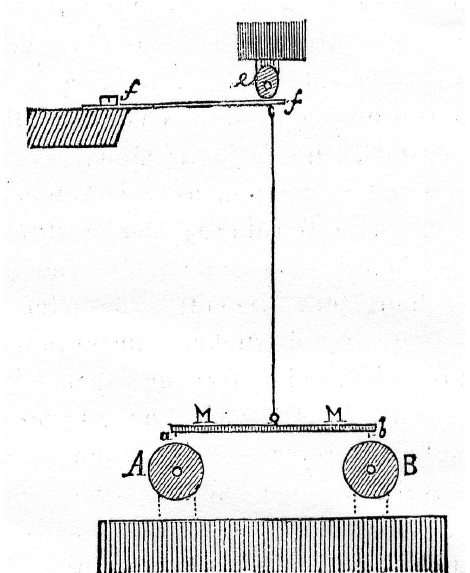
Figure 4. Automatic recording system developed by Lamont in 1847 for the hourly recording of temporal variations of geomagnetic parameters consisting of wax-coated slowly rotating cylinders. Ev- ery hour the suspended magnet is lowered and tips at the bottom of the magnet punch depressions into the wax. The data could be read with a microscope of small